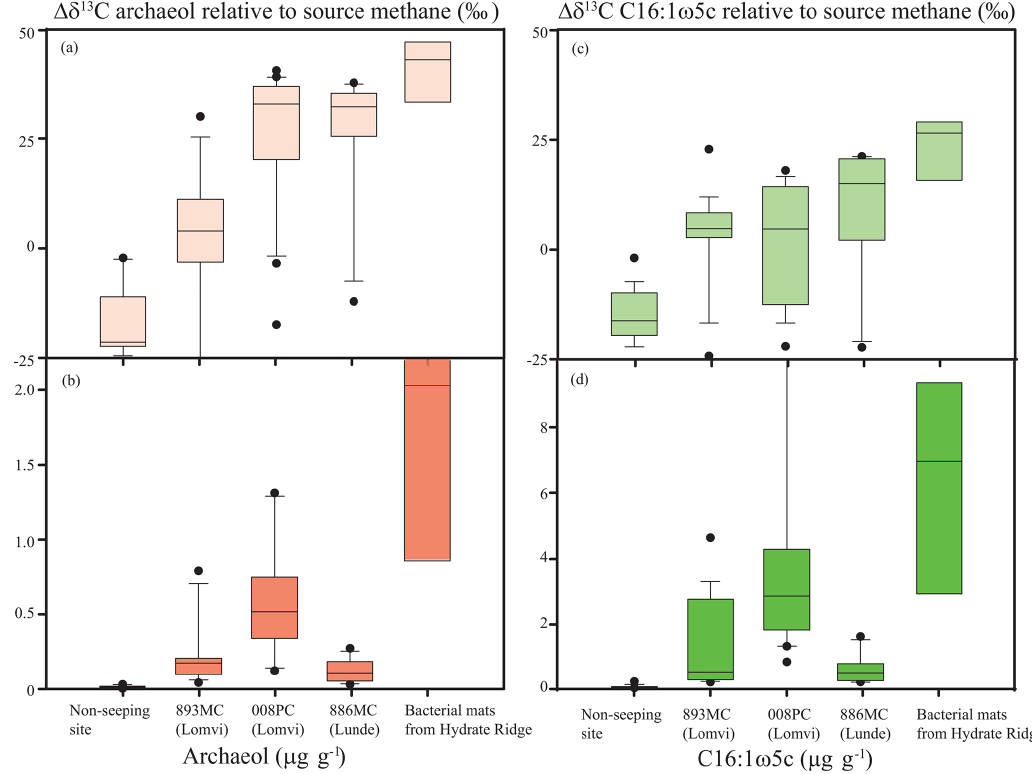
Figure 5. Average lipid biomarker concentrations and isotopic differences to source methane of the archaeal lipid archaeol ( (cid:49)δ 13 C) (a, b) and the bacterial fatty acid C16 : 1 ω 5c (c, d) . Cores Lomvi 893MC (averaged from 0–35cm), Lomvi 008PC (averaged from 0–33cm), and Lunde 886MC (averaged from 0–38cm) are compared to a high flux site at Hydrate Ridge (Elvert et al., 2005) and a core from a non-seeping site south of Svalbard (1522GC, 76.107 ◦ N, 15.957 ◦ E, averaged from 0–350cm; Yao et al.,